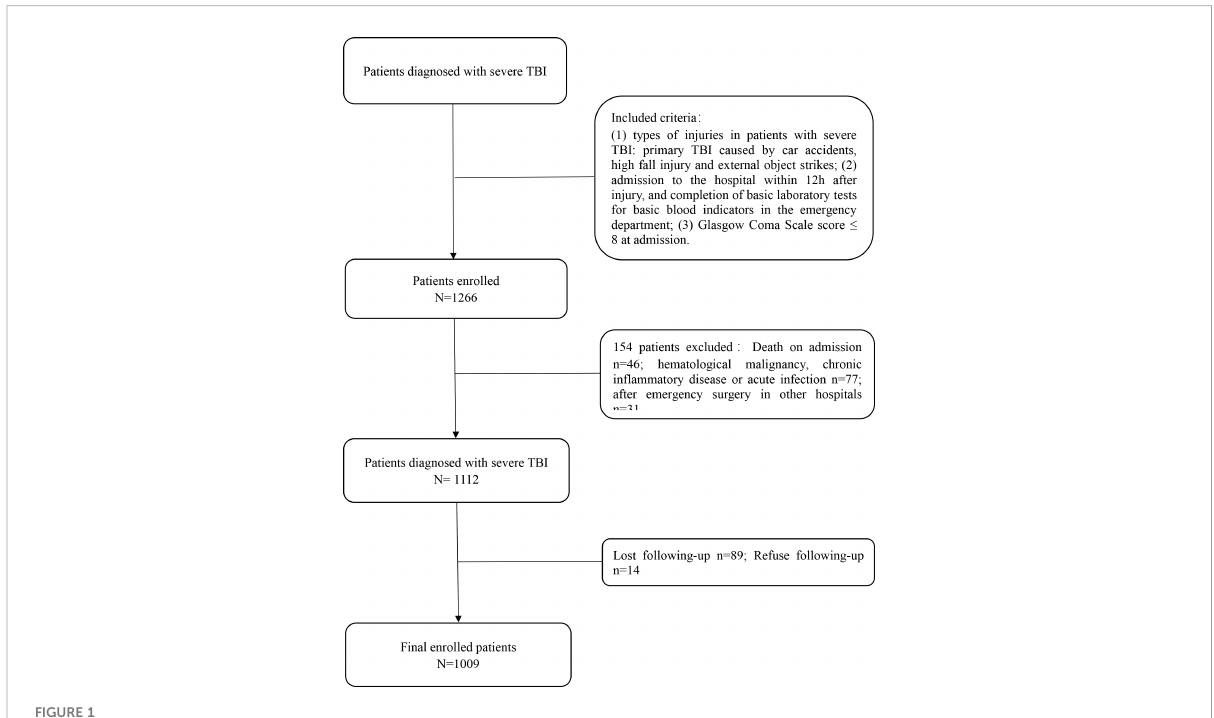
FIGURE 1 Flow chart for patients ’